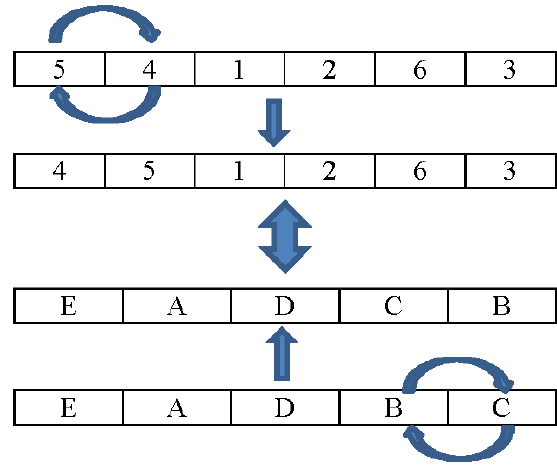
Figure 3. An example of the local search.